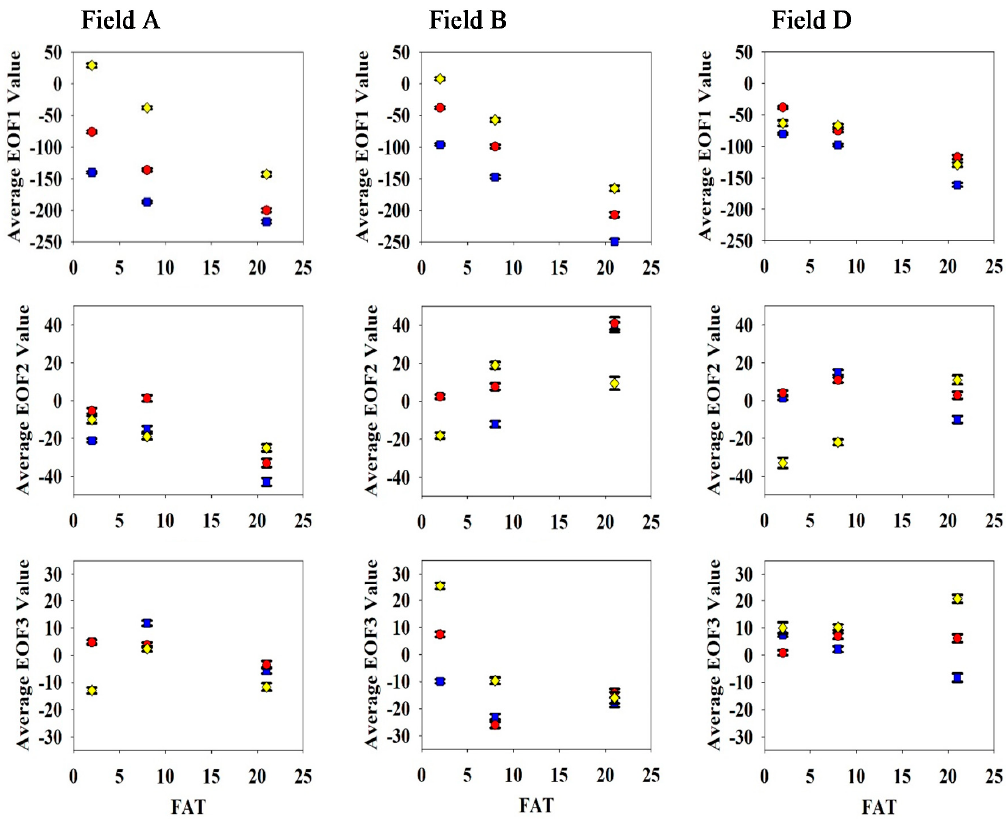
Figure 6. Effect of the flow accumulation threshold (FAT) on the average EOF values across buffer zones created with different distances from the hypothetical subsurface flow pathways: 0 to 5 m buffer, 5 to 10 m buffer, 10 to 15 m buffer.